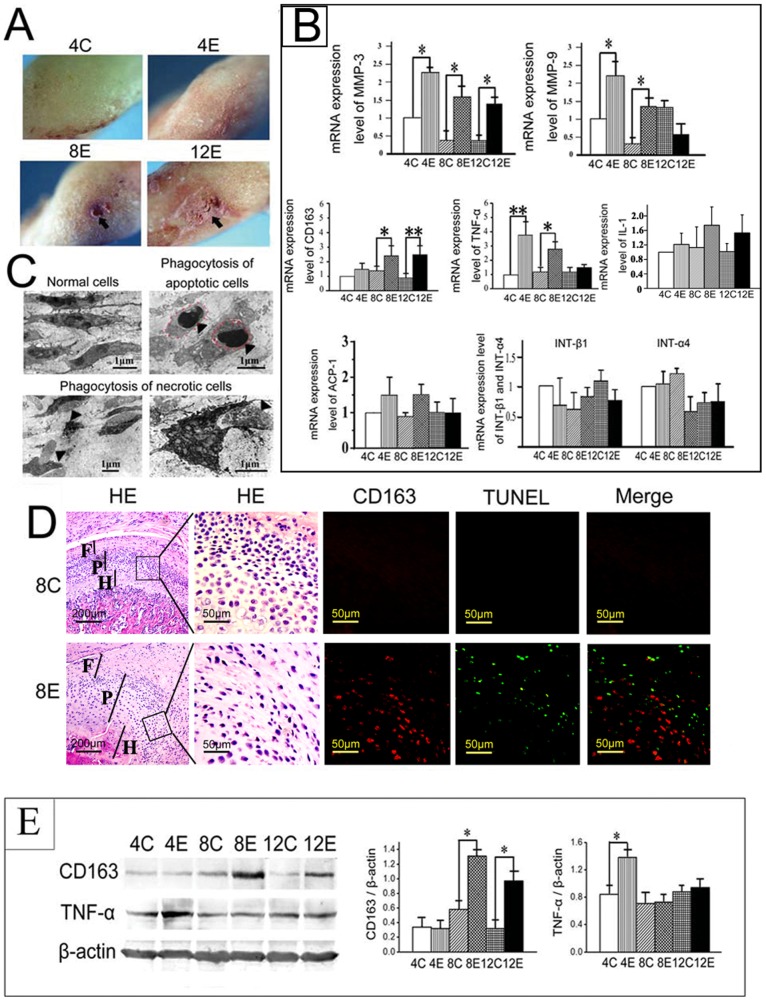
Enhanced phagocytic activity and increased CD163 and TNF-α expression in degraded TMJ cartilage.A: The gross surface morphology of rat temporomandibular joint (TMJ) condyles from control (4C) and experimental (4E, 8E, 12E) groups. Pit lesions are indicated by arrows. B: Comparison of the mRNA levels of MMP-3, MMP-9, CD163, TNF-α, IL-1, ACP-1, integrin-β1 and integrin-α4 in the condylar cartilage of control (C) and experimental (E) groups. C: Transmission electron micrographs of TMJ cartilage from control group (left top panel) and the regions with grossly damaged cartilage from experimental groups (the others panels). The apoptotic (outlined with the red dashed line) and necrotic chondrocytes are shown by arrow heads. Note that within the degraded TMJ cartilage some cells were phagocytizing neighboring apoptotic and necrotic cells. D: Serial sections of condylar cartilage from the 8-week old control (upper panels) and experimental (lower panels) groups, stained with H&E (HE), or co-stained with CD163 and TUNEL. F: fibrous layer; P: proliferative layer; H: hypertrophic layer. E: Comparison of the protein levels of CD163 and TNF-α in the condylar cartilage of control (C) and experimental (E) groups by Western blotting (left panel). Graph representing the quantification of the Western blotting results, normalized to the expression of β-actin. *P<0.05, **P<0.01. 4C: 4-week old control group; 4E: 4-week old experimental group; 8C: 8-week old control group; 8E: 8-week old experimental group; 12C: 12-week old control group; 12E: 12-week old experimental group.